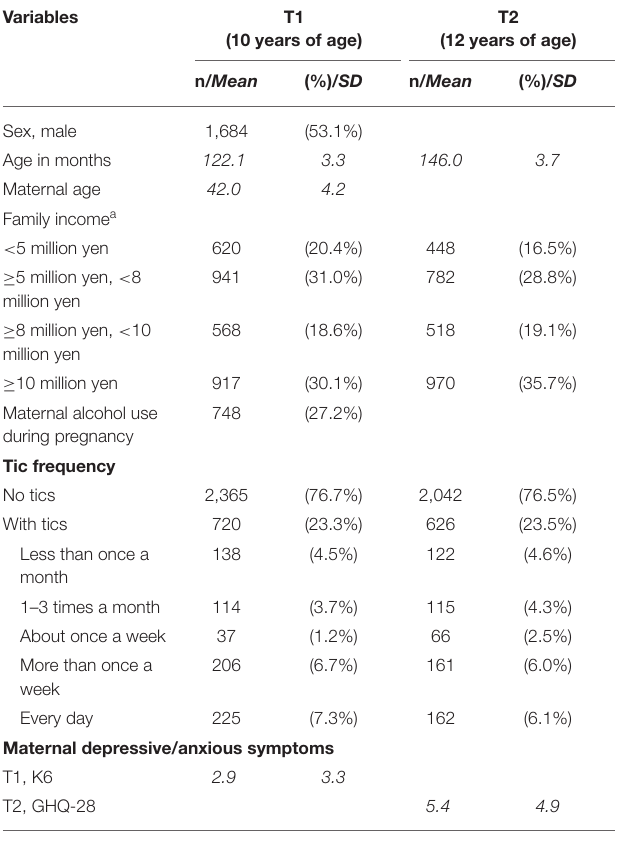
TABLE 1 | Demographic characteristics of the